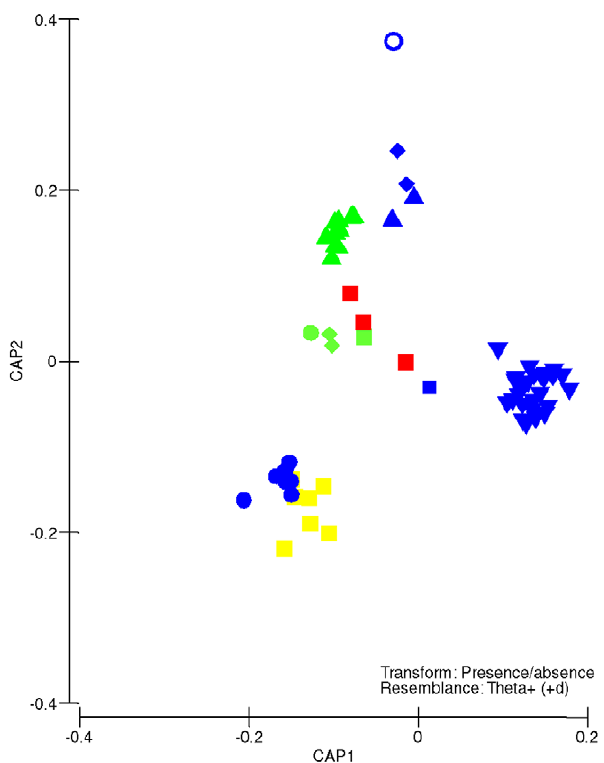
Figure 3. CAP on biological data. Canonical analysis of principal coordinates (CAP) plots generated from taxonomic dissimilarity coefficients ( theta ) of the biological data matrix, using LMEs as predictor factor. Green triangle = Gulf of Alaska, Yellow square = Agulhas Current, Red square = Mediterranean Sea, Blue triangle = Celtic-Biscay Shelf, Green diamond = Gulf of California, Blue diamond = Northeast US Continental Shelf, Inverted blue triangle = Caribbean Sea, Blue circle= Benguela Current, Green square = South China Sea, Green circle = Kuroshio Current, Blue square = Patagonian Shelf, Empty blue circle = Scotian Shelf.